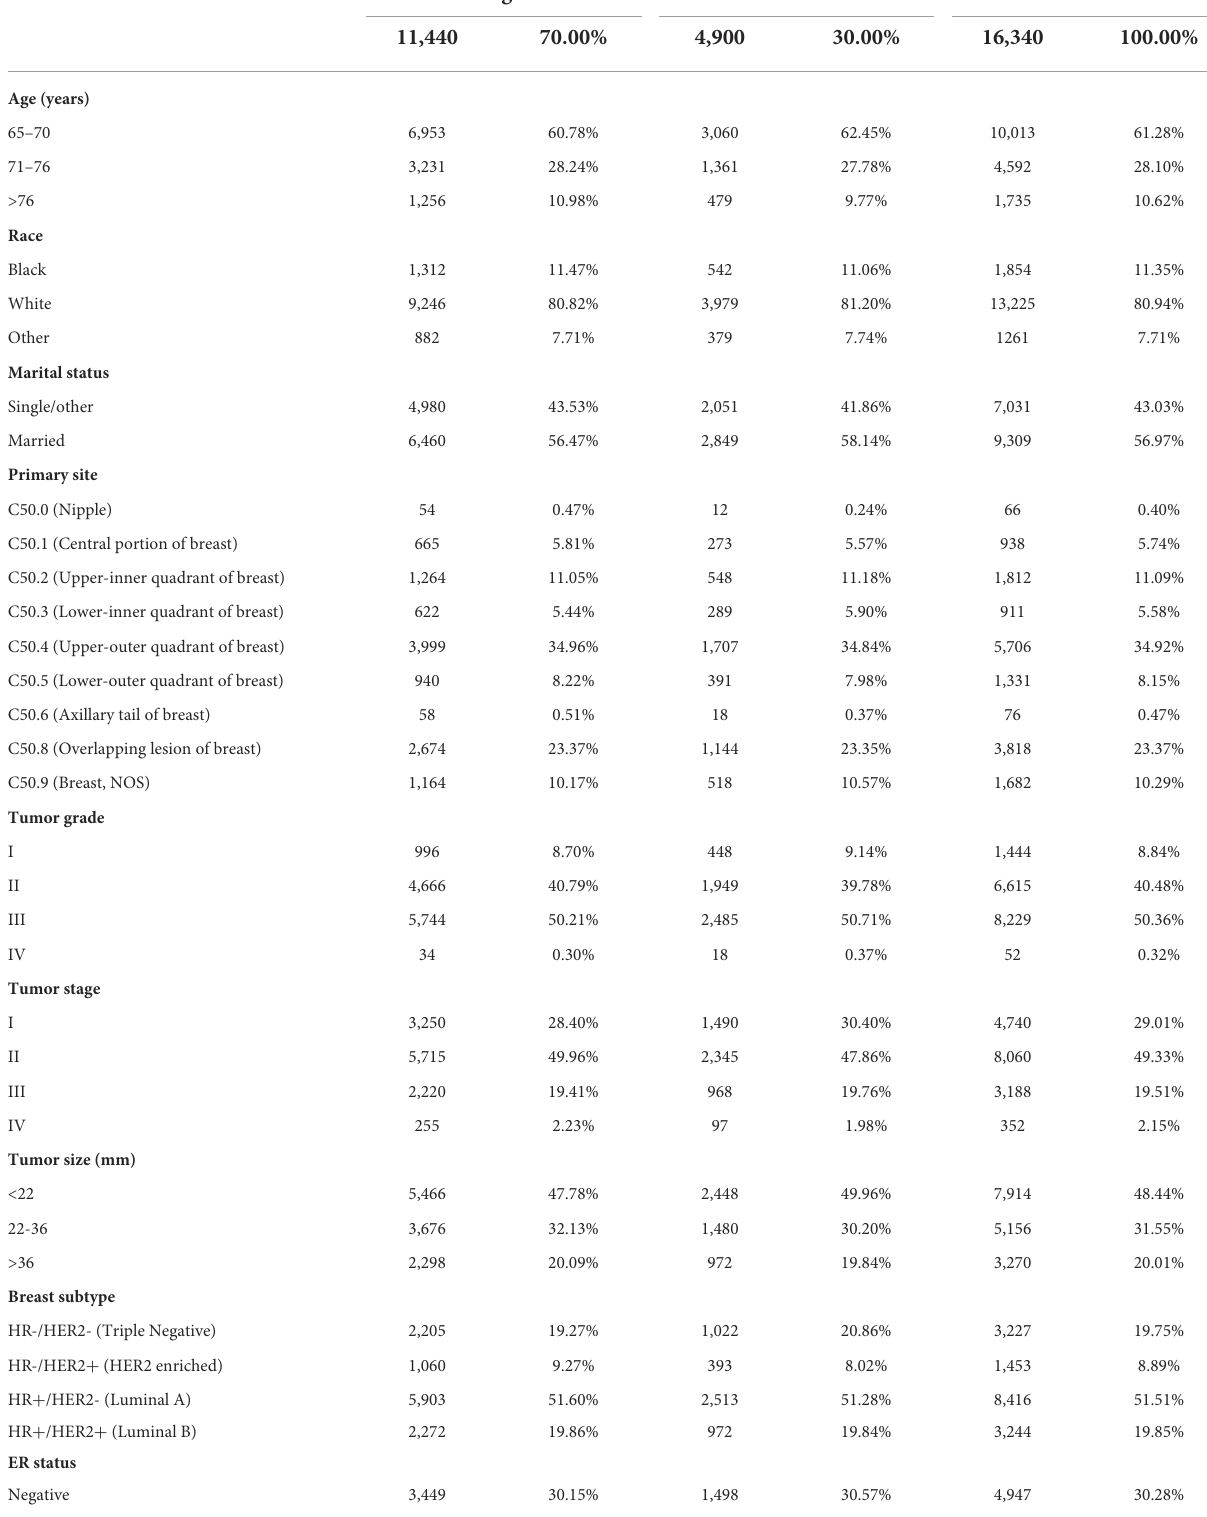
TABLE 1 The baseline demographic and clinicopathologic characteristics of the HDSS-related variables of older female primary breast cancer patients that underwent chemotherapy.